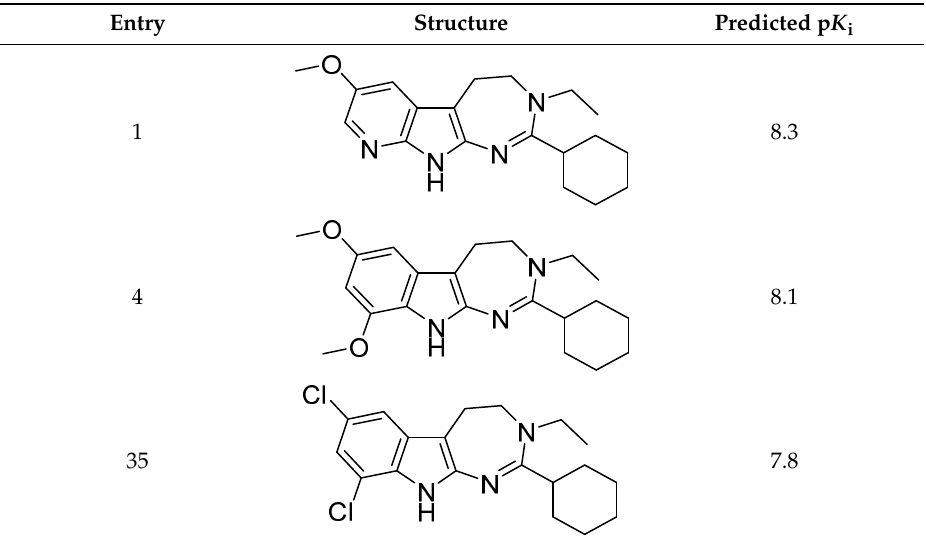
Table 2. Structure and predicted p K i values of the selected ibogaine derivatives resulted from the scaffold-hopping study of Series 2.